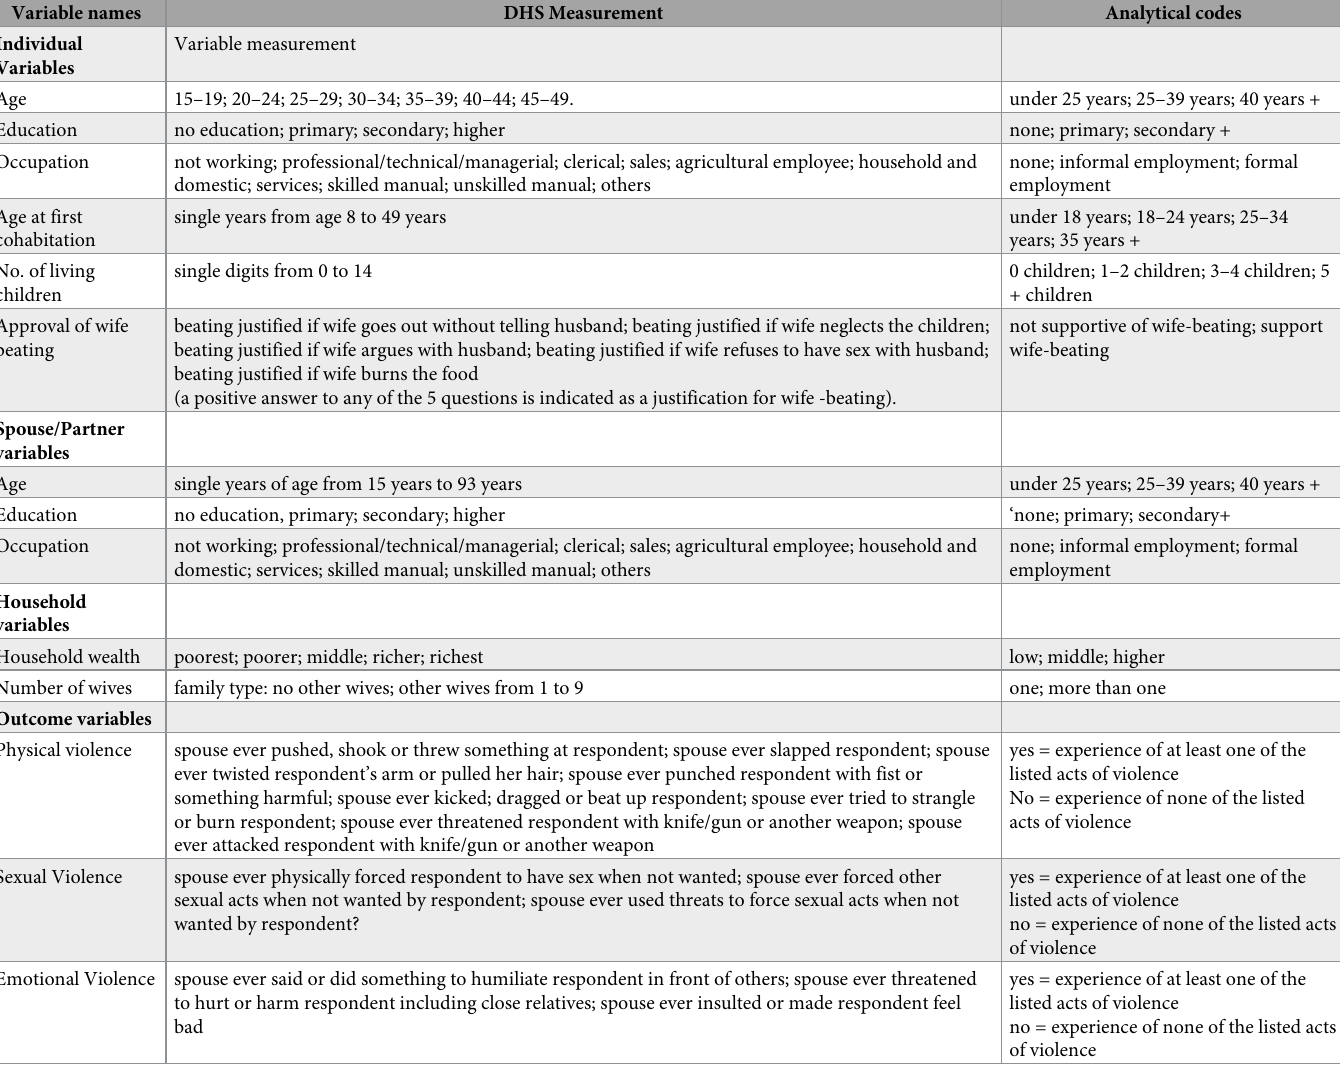
Table 2. DHS definition of variables and